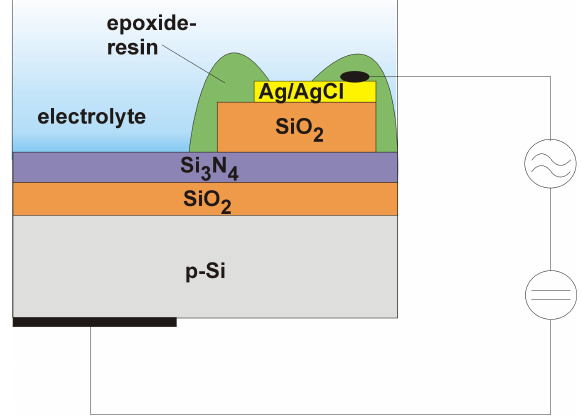
Figure 2. Cross section of the pH sensor (thin-film) with miniaturised reference electrode (thick-film) together on one silicon